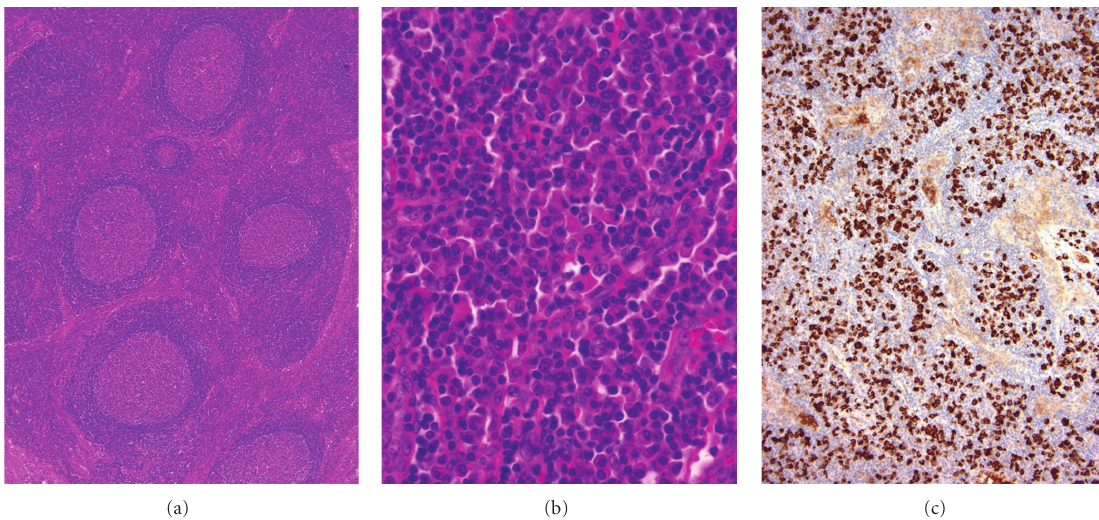
Figure 7: Rheumatic lymphadenopathy with abundant IgG4 + cells. (a), (b) The lymph node shows marked follicular hyperplasia and interfollicular plasmacytosis with small lymphocytes; eosinophil infiltration is absent. (c) The majority of mature plasma cells are positive for IgG4 (IgG4 + /IgG + plasma cell ratio >